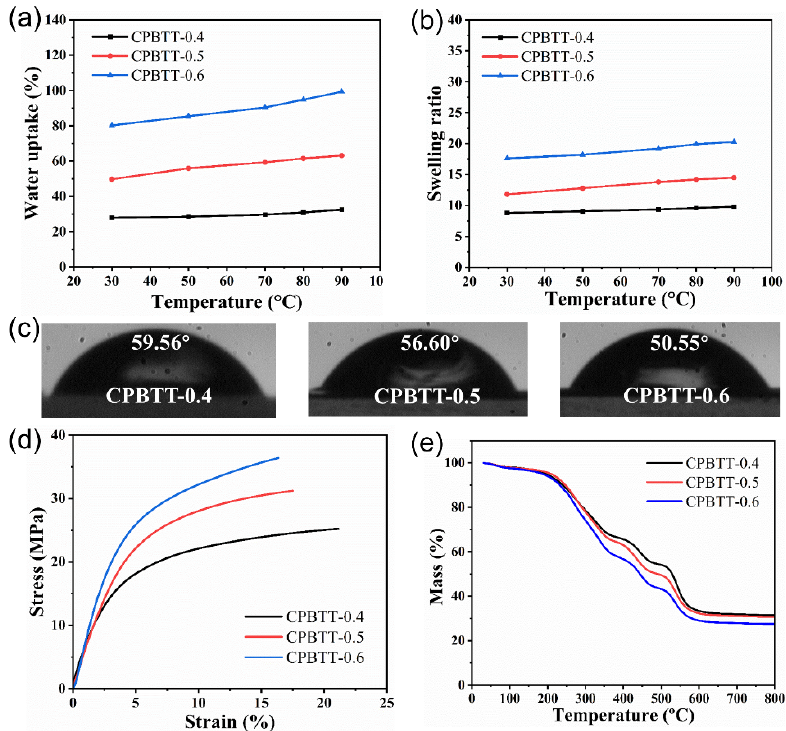
Figure 4. ( a ) Water uptake and ( b ) swelling ratio of the CPBTT − x AEMs at different temperatures. ( c ) the water contact angle of the CPBTT − x AEMs. ( d ) stress − strain curves and ( e ) TGA curves of the CPBTT − x AEMs.